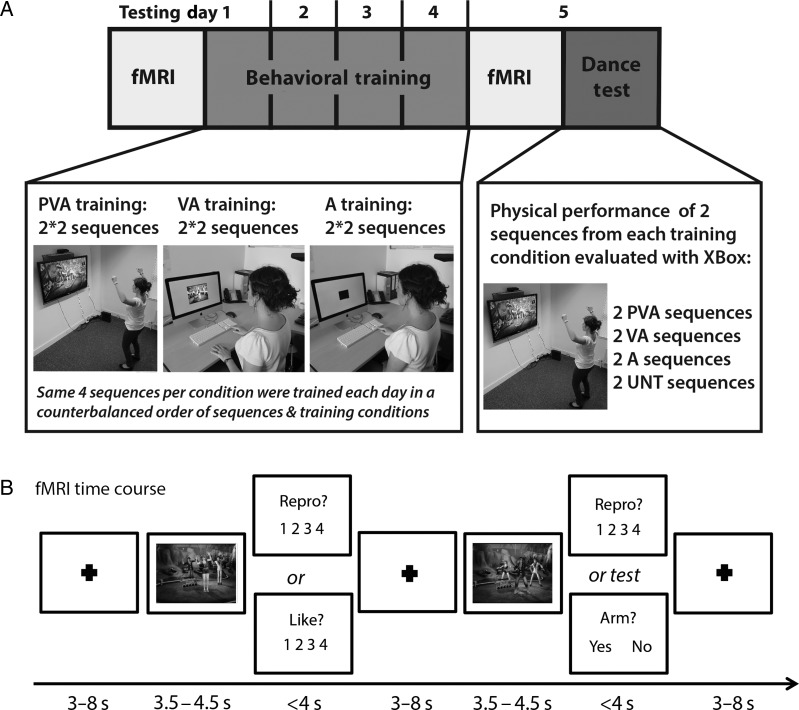
(A) Experimental design depicting the phases of the study in chronological order. All participants completed 2 identical fMRI sessions, 4 consecutive days of behavioral training and a final dance test. Representation of the 3 training conditions: physical, visual, and auditory experience (PVA), visual and auditory experience (VA), auditory experience only (A). Participants learned 2 distinct sequences in each training condition, but practiced or watched/listened to each sequence twice on each of the 4 days of training (for the PVA and VA conditions, once with a male and once with a female avatar). For the dance test on Day 5, participants performed all 8 sequences once in a counterbalanced order. (B) Time course of each fMRI trial. After a fixation screen (length pseudo-logarithmically randomized between 3 and 8 s), participants watched a 5-s dance movement, and were then asked to rate each movement on one of two dimensions: either “How much did you like the movement you just watched?” or “How well could you reproduce the movement you just watched.” Participants responded via a button press, on 4-point Likert scale. The question remained on the screen until a response was made or a maximum of 4 s. Six additional videos randomly appeared and were followed by one of several attentional control questions that required a yes or no response (e.g., “Did the dancer place at least one arm above their head?”).